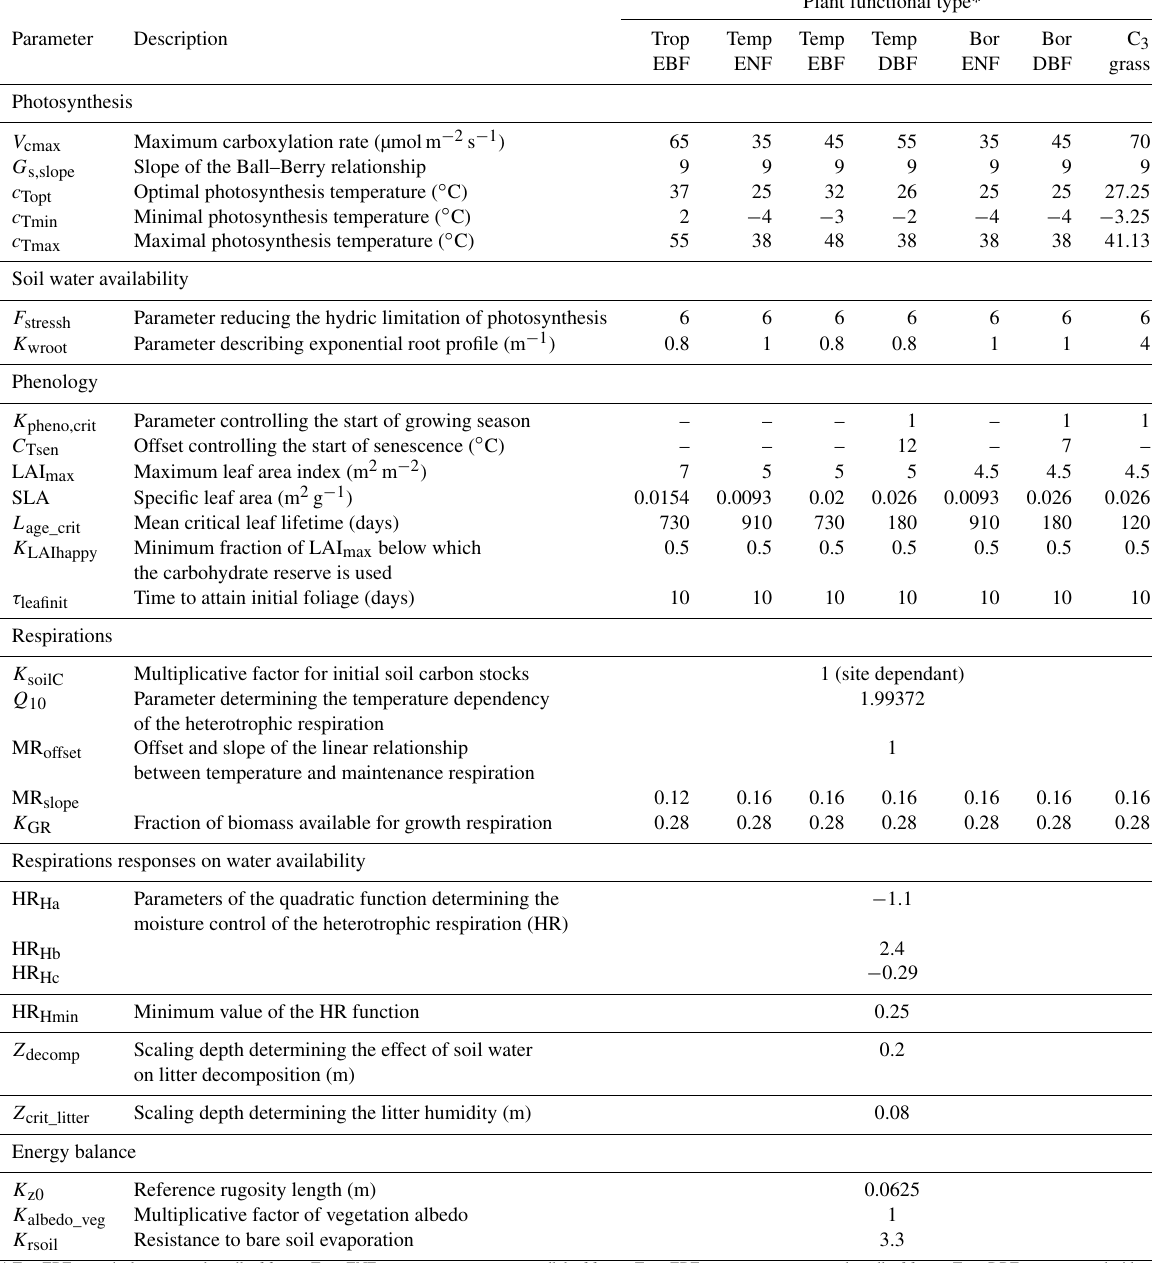
Plant functional